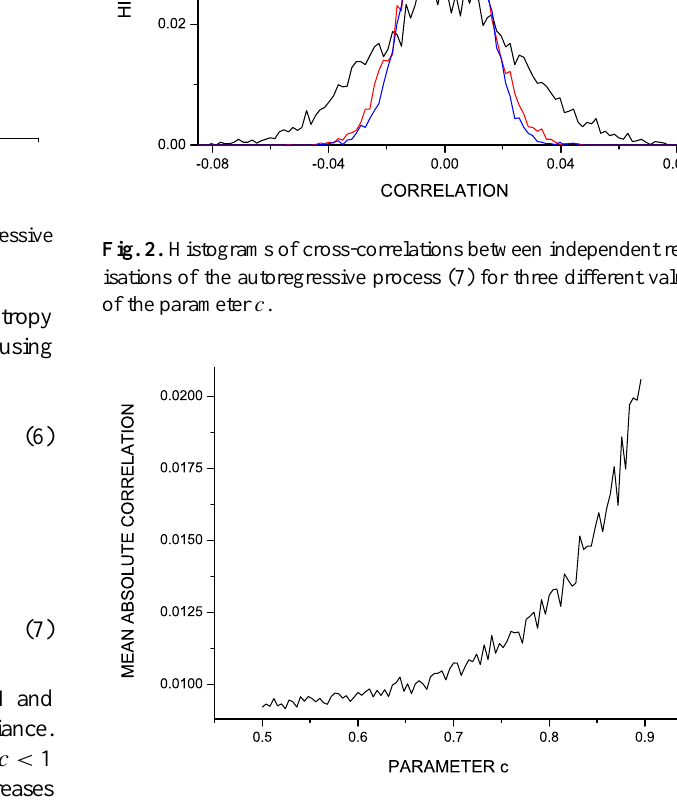
Fig. 3. Dependence of the mean absolute cross-correlation between independent realisations of the autoregressive process (7) on the pa- rameter c